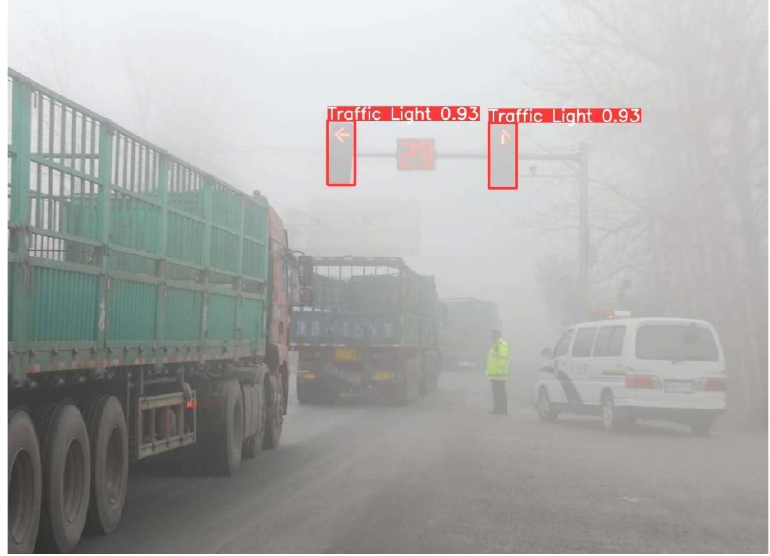
Figure 7. YOLOv5s fog detection image output results.